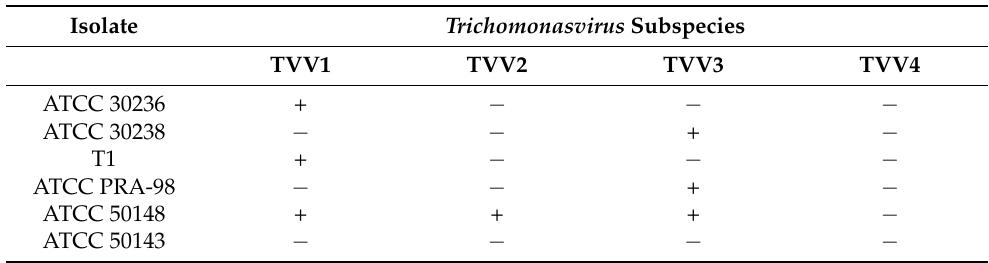
Table 1. The presence or absence of the Trichomonasvirus (TVV) subspecies in each proteome of small extracellular vesicles (sEVs) by LC-MS/MS.